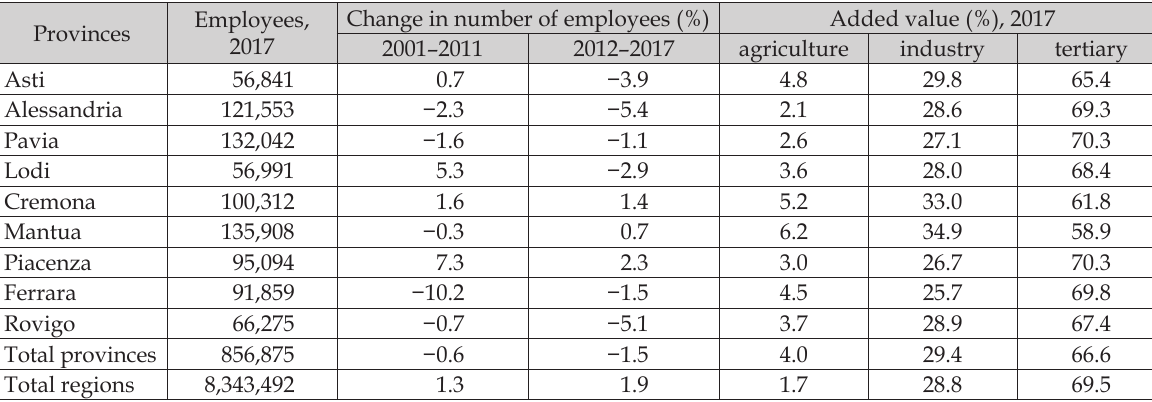
Table 2. Employees at local units and composition of added value: provinces of the study area (2001–2017). Provinces